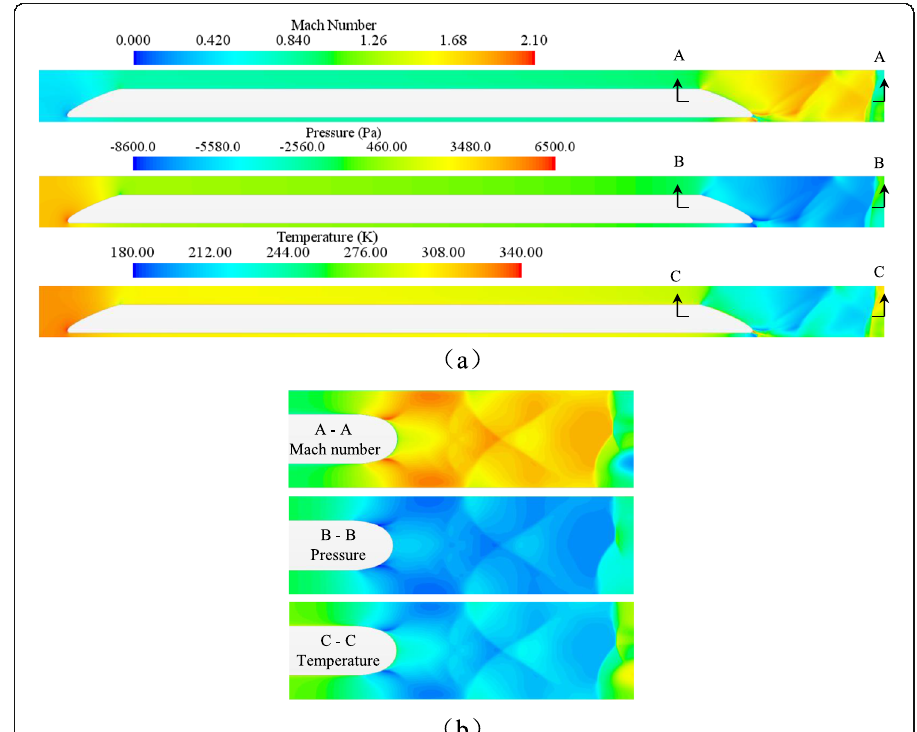
Fig. 12 The contours of pressure coefficient, temperature and Mach number: a The longitudinal section of the flow field around the train; b The horizontal cross-section of the wake area